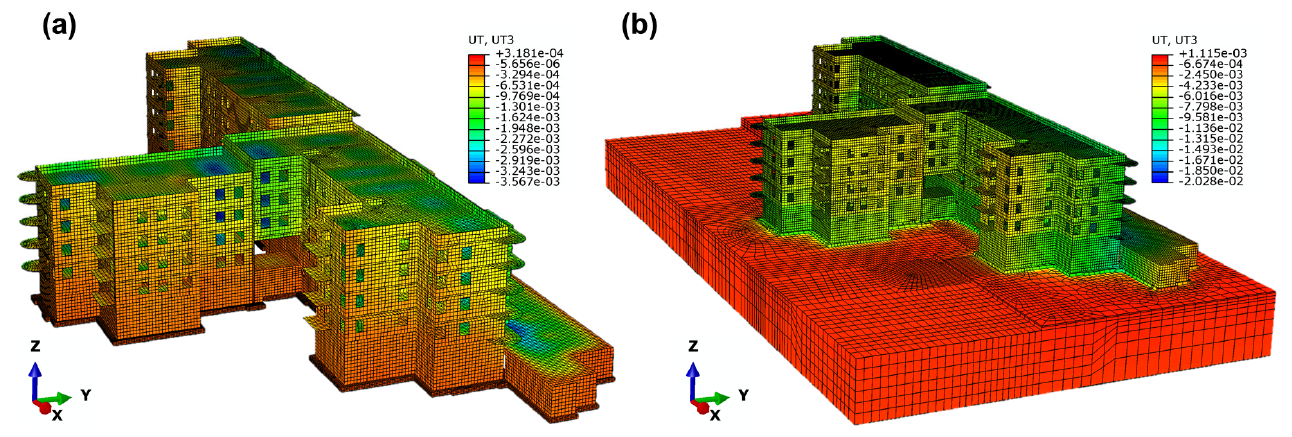
Figure 16. Maps of final vertical displacements [m]: ( a ) RIGID model, ( b ) AREA model.